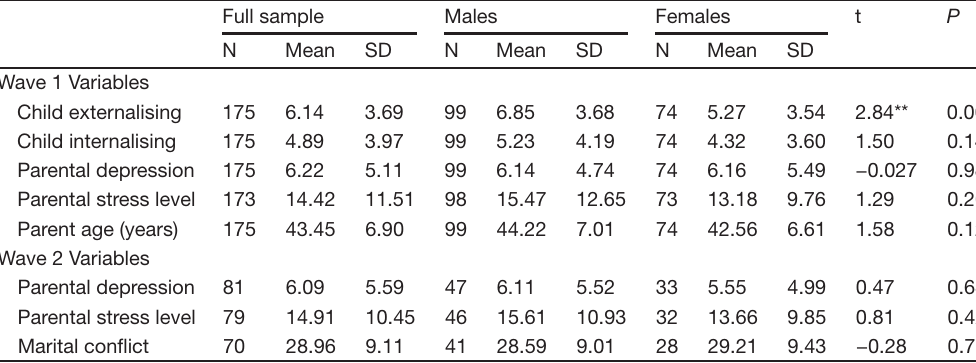
Table 1. Descriptive statistics for the full sample and by child sex